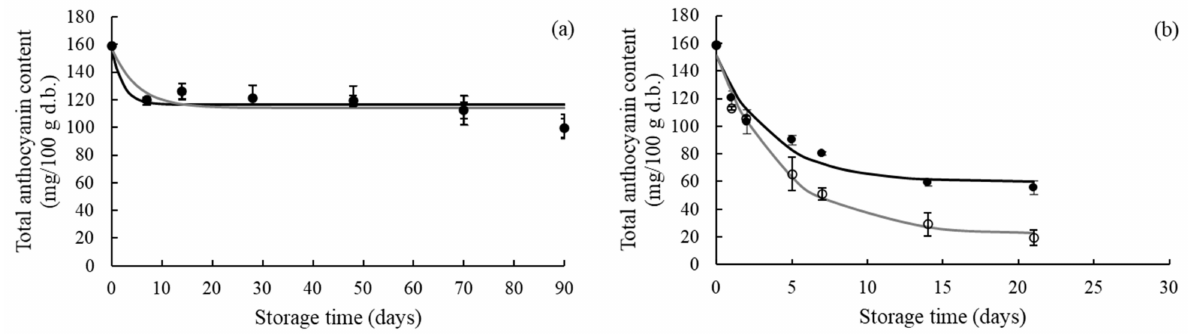
Figure 3. Evolution of the total anthocyanin content of strawberry leather during storage at 22.5% RH ( a ) and 52.3% RH ( b ), with no illumination ( • ) and with illumination ( bols represent experimental data. The full lines represent the first-order fractional conversion